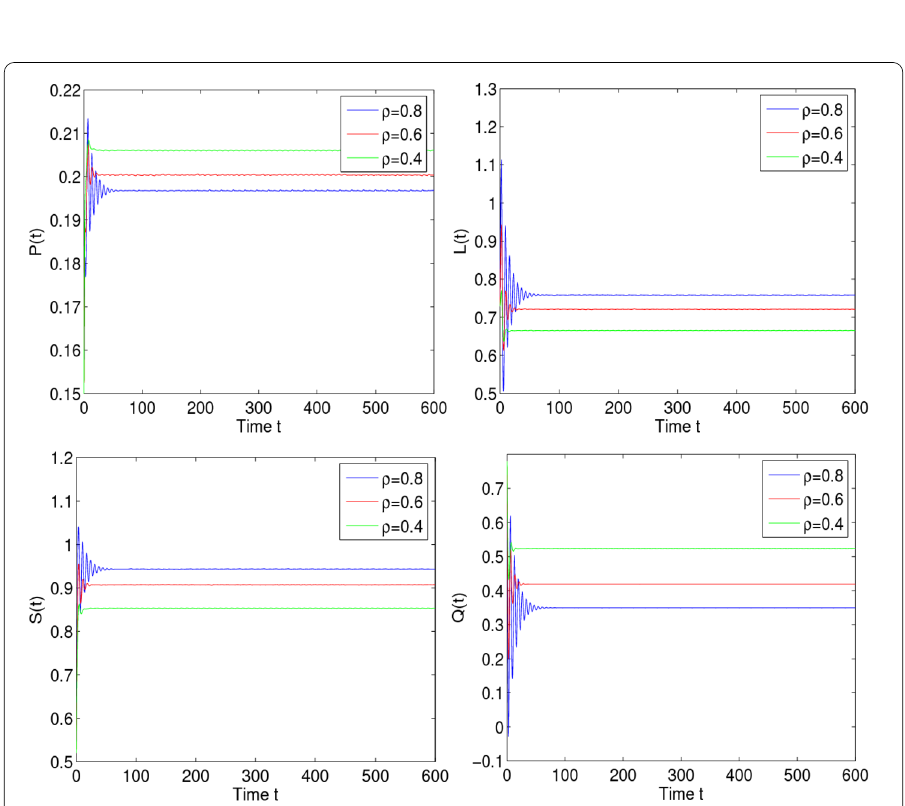
Figure 8 Time plots of P , L , S and Q for different ρ at τ = 2.0505. The rest of the parameters are taken as given in the text